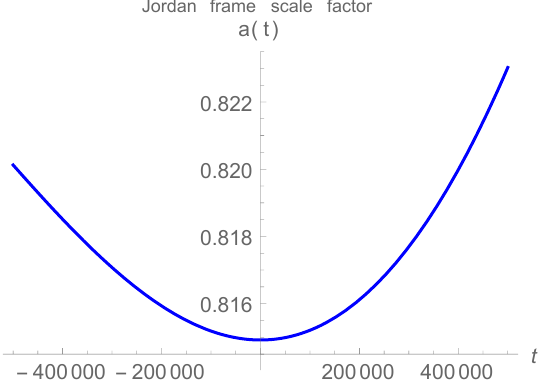
Figure 4. Time evolution of the scale factor in the Jordan frame for a bounce in radiation background in exponential gravity found with the initial conditions φ ( 0 ) = 0.1, φ (cid:48) ( 0 ) = 10 − 7 , ˜ H ( 0 ) =